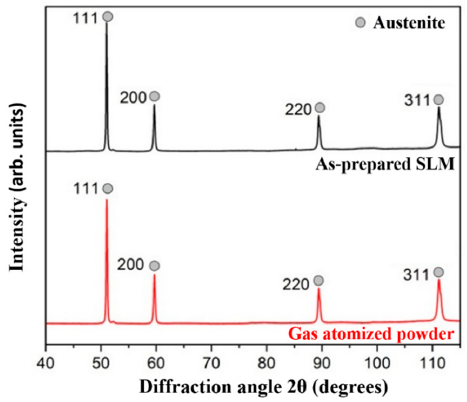
Figure 4. X-ray diffraction patterns of the gas-atomized 316L powder and the sample produced by selective laser